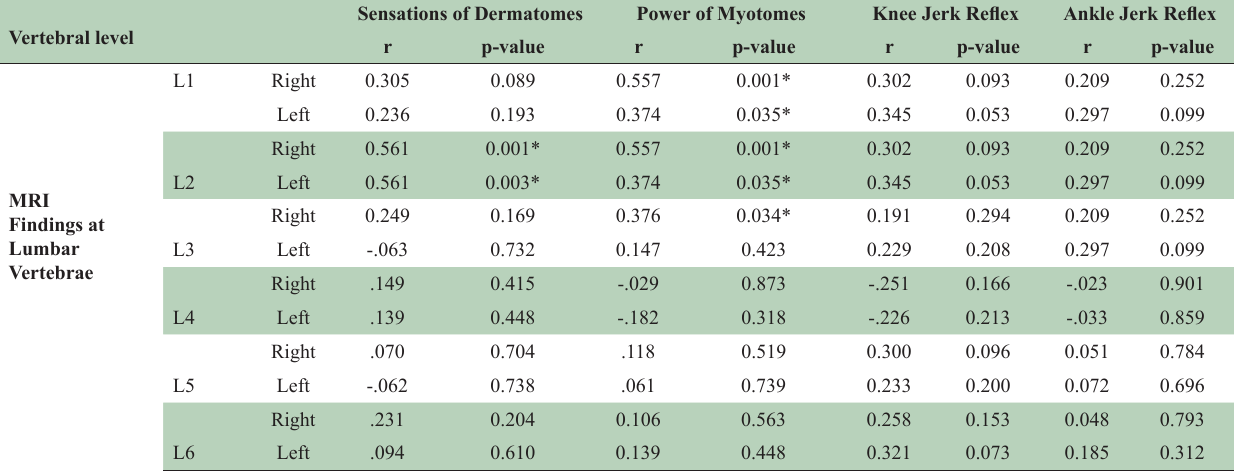
Table-II shows a negative correlation between pain intensity and MRI findings at L1-L2, L2-L3, L4-L5 and L5-S1 but at L3-L4, this shows a positive correlation between pain intensity and MRI findings but the results are insignificant. Table-III: Correlation among MRI findings and clinical findings